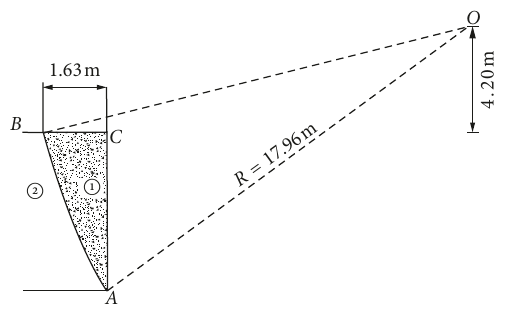
Figure 9: The schematic of coal wall safety partition. Table 4: Comparison of calculated and measured values of each